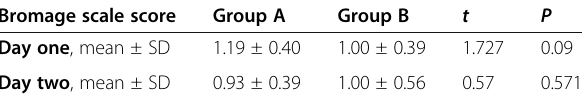
Table 2 Comparison between the two groups regarding pain at 6, 12, 18, 24, 30, 36, 42, and 48 h after surgery